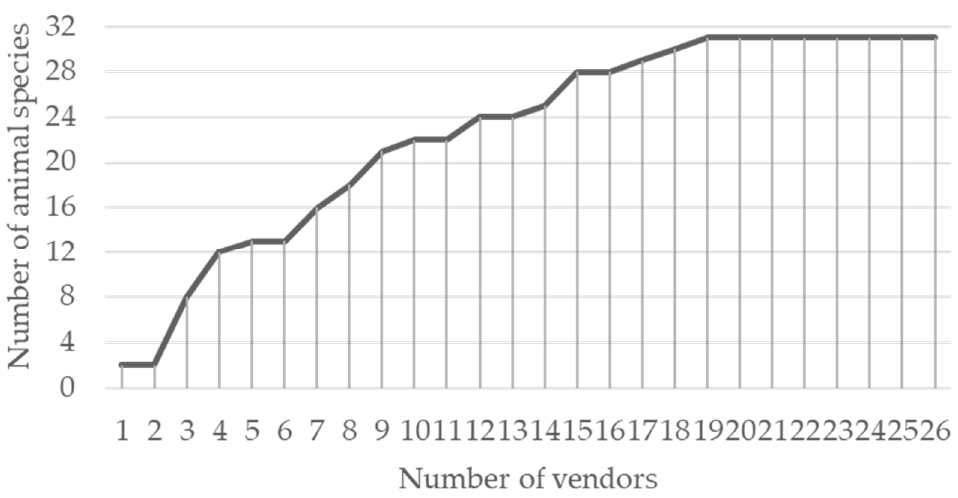
Figure 1. Cumulative number of medicinal animal species sold by 26 vendors sampled in the Kumasi Central Market.